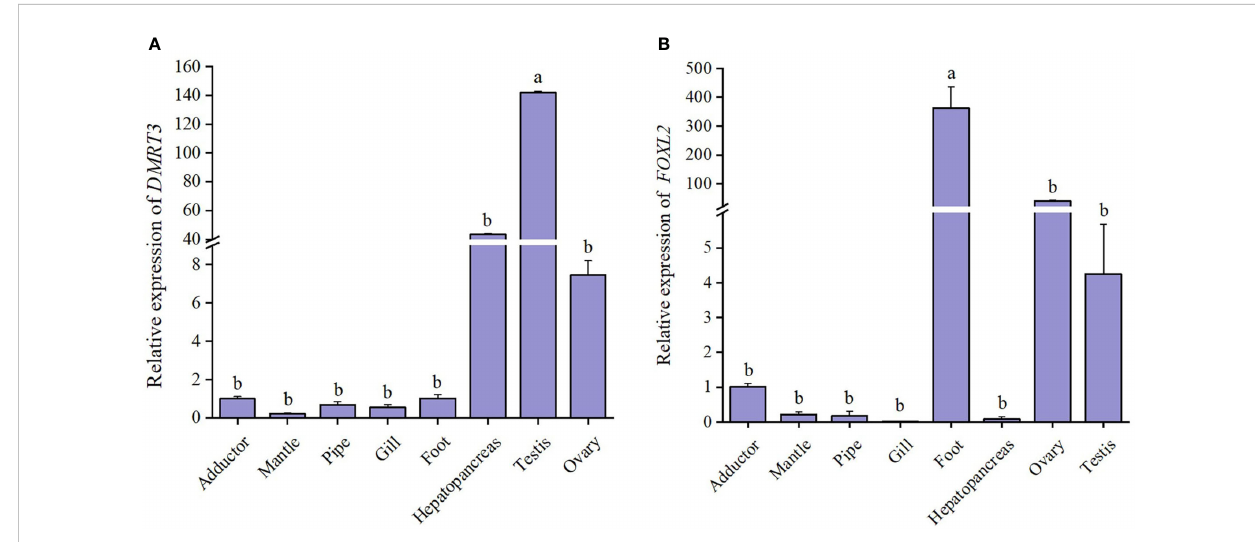
FIGURE 5 The relative expression levels of DMRT3 (A) and FOXL2 (B) in different tissues of C. sinensis . Different letters represent signi fi cant differences ( P<0.05